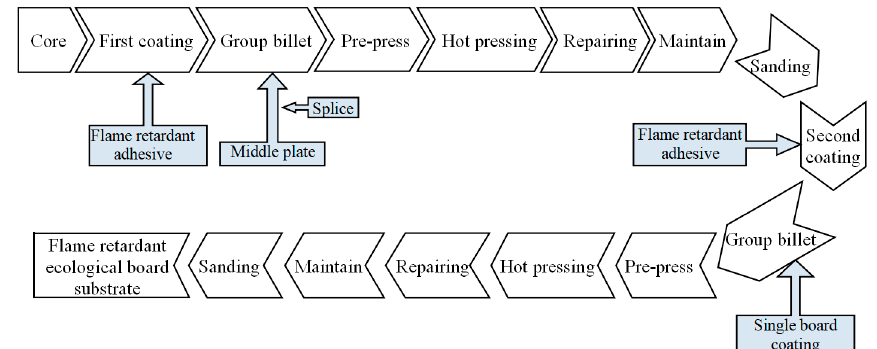
Polymers 2020 , 12 , x FOR PEER REVIEW Figure 1. Structure diagram of impregnated film paper veneer blockboard. Figure 1. Structure diagram of impregnated film paper veneer blockboard.